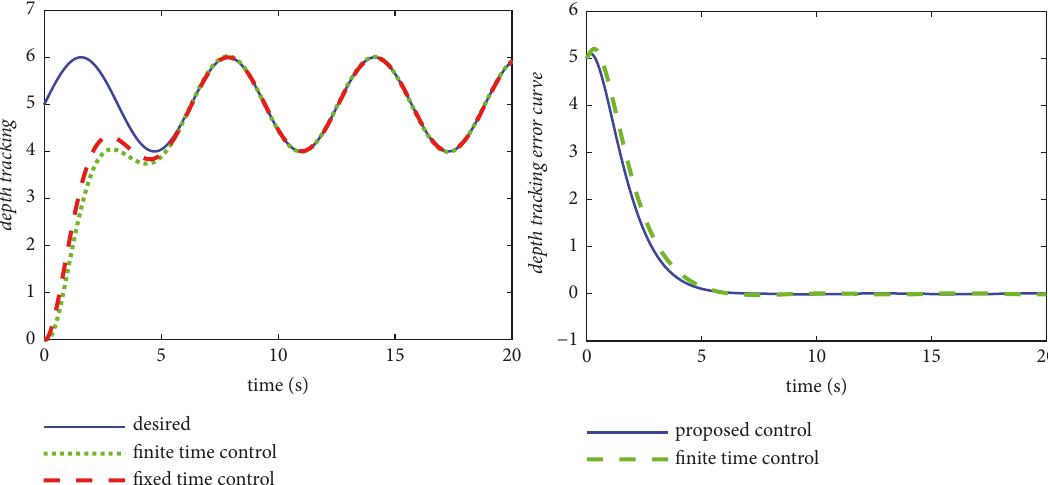
Figure 10: The depth tracking trajectory curve and its error cure for the case of existing dead-zone